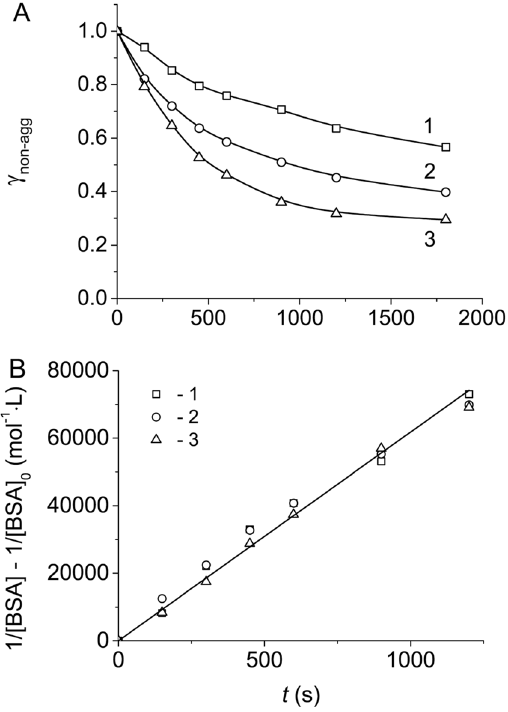
Figure 1. Kinetics of BSA aggregation registered by AF4 (0.1 M Na-phosphate buffer, pH 7.0, 70 °C). ( A ) The dependences of the portion of non-aggregated protein ( γ non-agg ) on time obtained at the following concentrations of BSA: 1 (1), 1.5 (2) and 1.75 mg∙mL − 1 (3). ( B ) The linear anamorphosis constructed in the coordinates {(1/[BSA] − 1/[BSA] 0 ); t